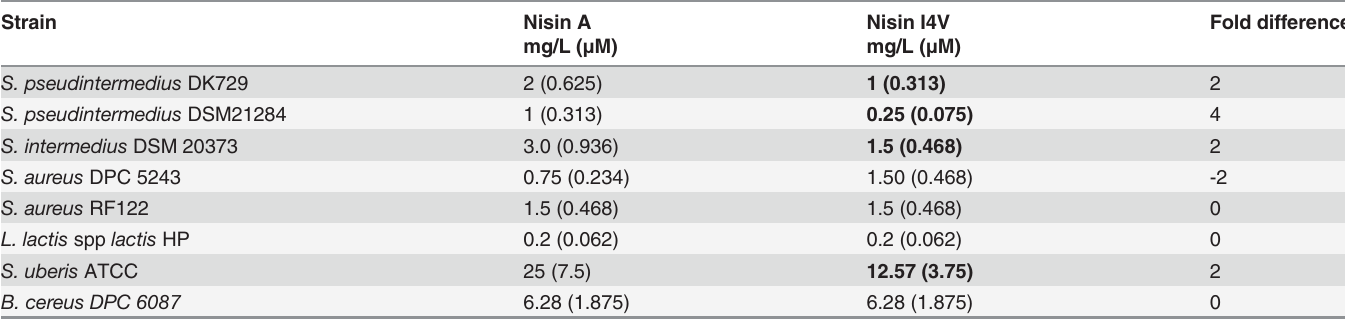
Results from minimum inhibitory concentration assays of puri fi ed nisin A and nisin I4V against various Gram-positive targets. Values given are identical results from three independent determinations. Fold Difference represents the improvement of I4V compared to nisin against the relevant